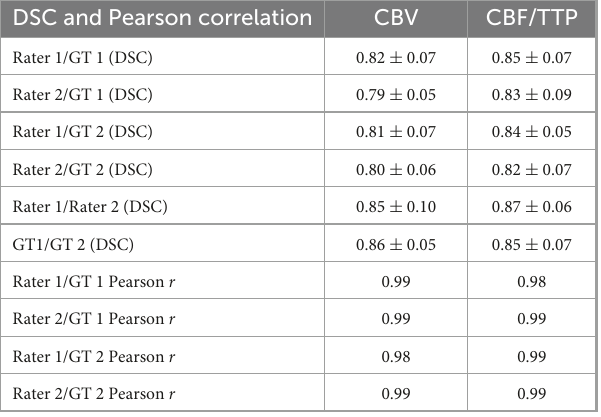
TABLE 2 Average DSC and lesion volumes Pearson correlations.